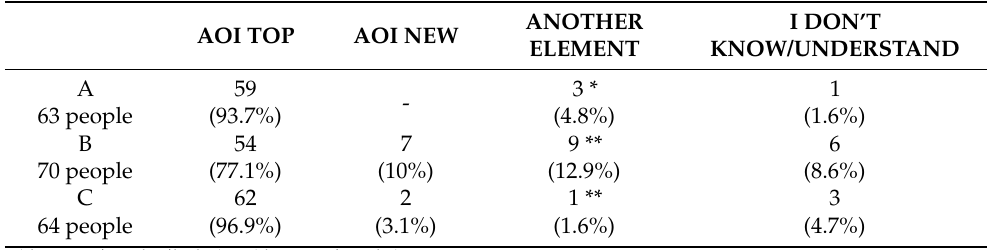
Table 4. Answers to the questionnaire. Participants were to choose the most important item within the image. They were allowed to choose more than one